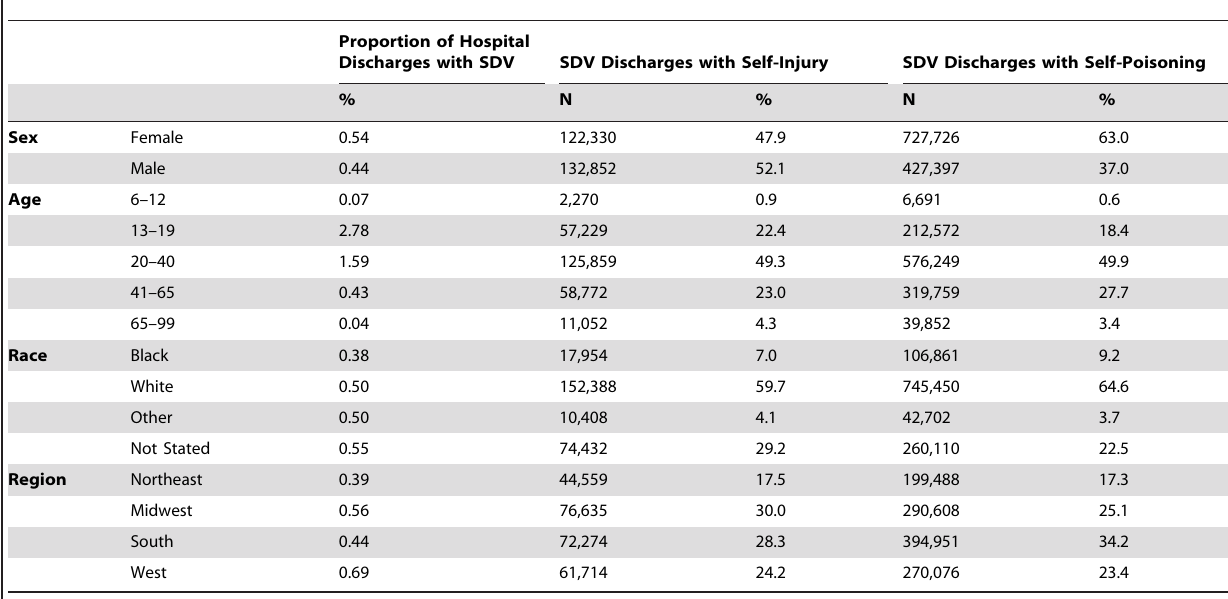
Table 1. Demographic characteristics of hospital discharges with non-fatal self-directed violence (SDV) resulting in injury or poisoning.